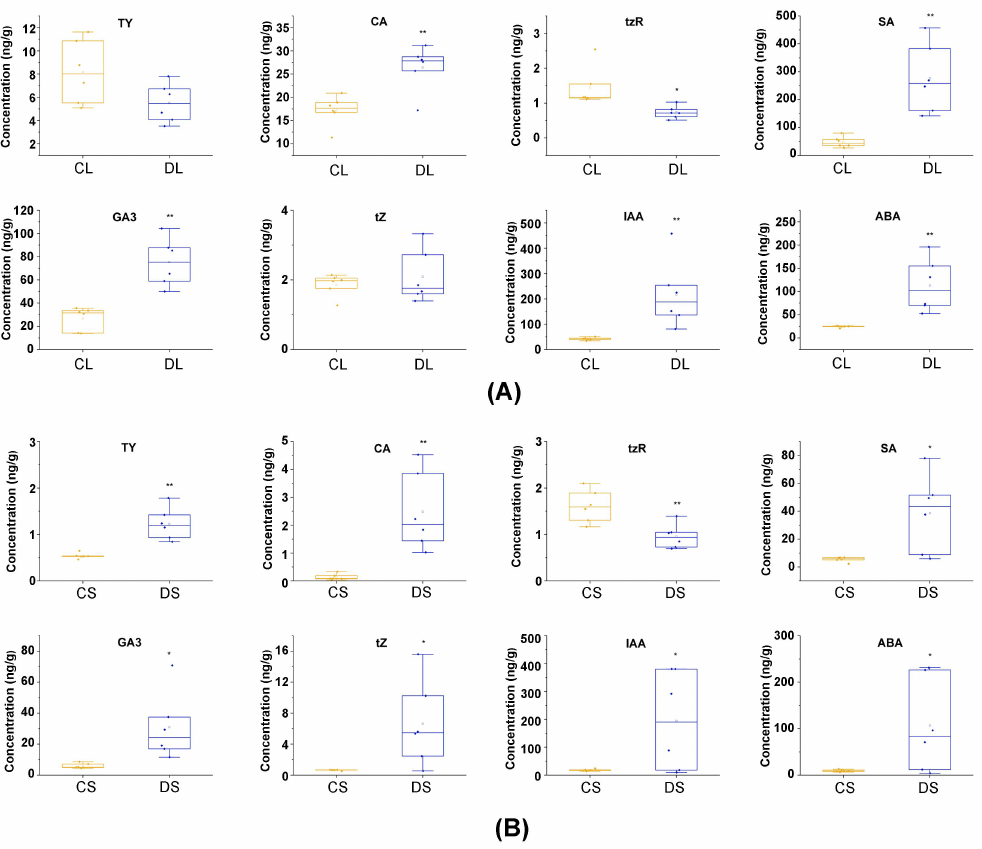
Figure 6. Changes of phytohormone content in ginseng leaves ( A ) and ginseng stems ( B ) when facing the infection of P. cactorum . The value of each sample is represented by a blue diamond, and the average value of each group is represented by a hollow square. ** represents very significant difference compared to the control group ( p < 0.01), * represents significant difference compared to the control group ( p < 0.05). TY: typhasterol; CA: castasterone; tZR: trans -zeatin riboside; SA: salicylic acid; GA3: Gibberellin A3; tZ: trans -zeatin; IAA: indole-3-acetic acid; ABA: indole-3-acetic acid.